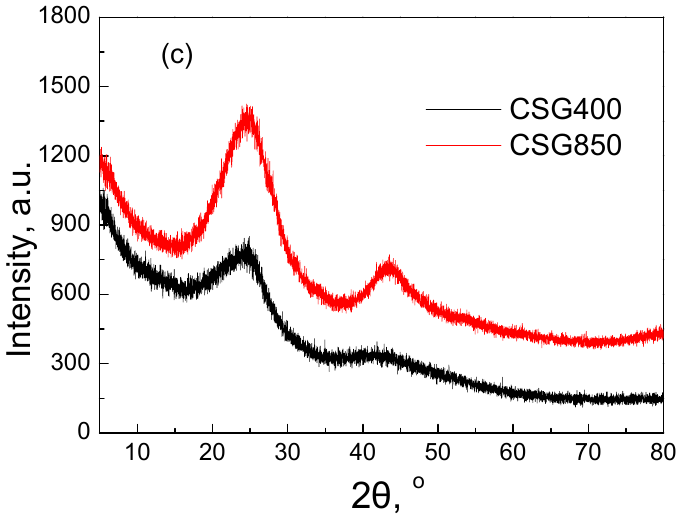
Figure 2. XRD patterns of the prepared biochars: ( a ) OK400 and OK850, ( b ) MSR400 and MSR850, ( c ) CSG400 and CSG850.